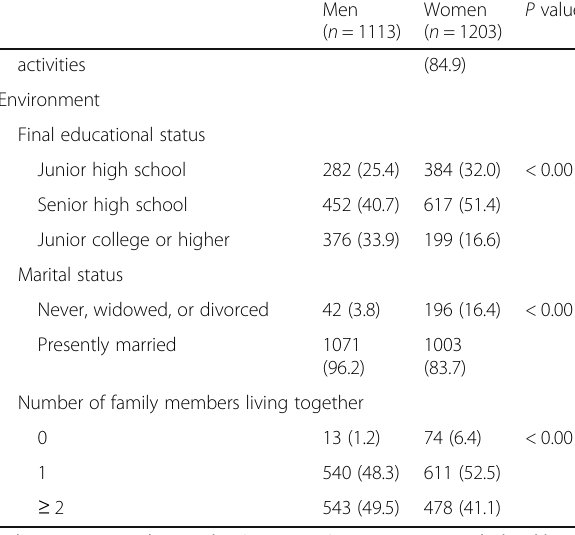
Table 1 Lifestyle and psychosocial characteristics of participants